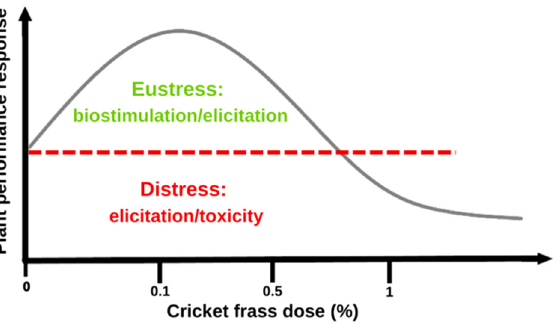
Figure 4. Graphical representation of the hormetic effect observed in tomato treated with frass in the substrate in the present study.